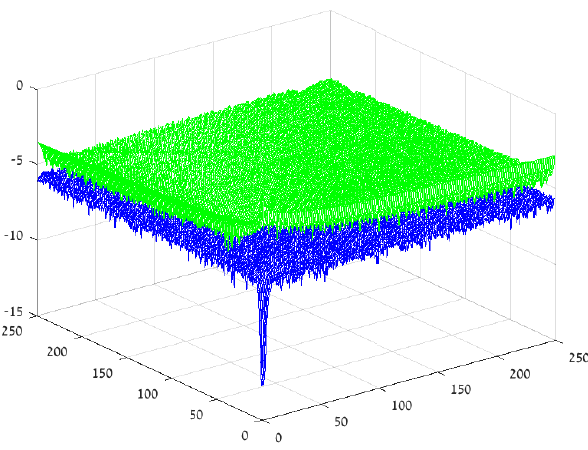
Figure 17. The magnitude reduction of the Fourier coefficients with D ¯